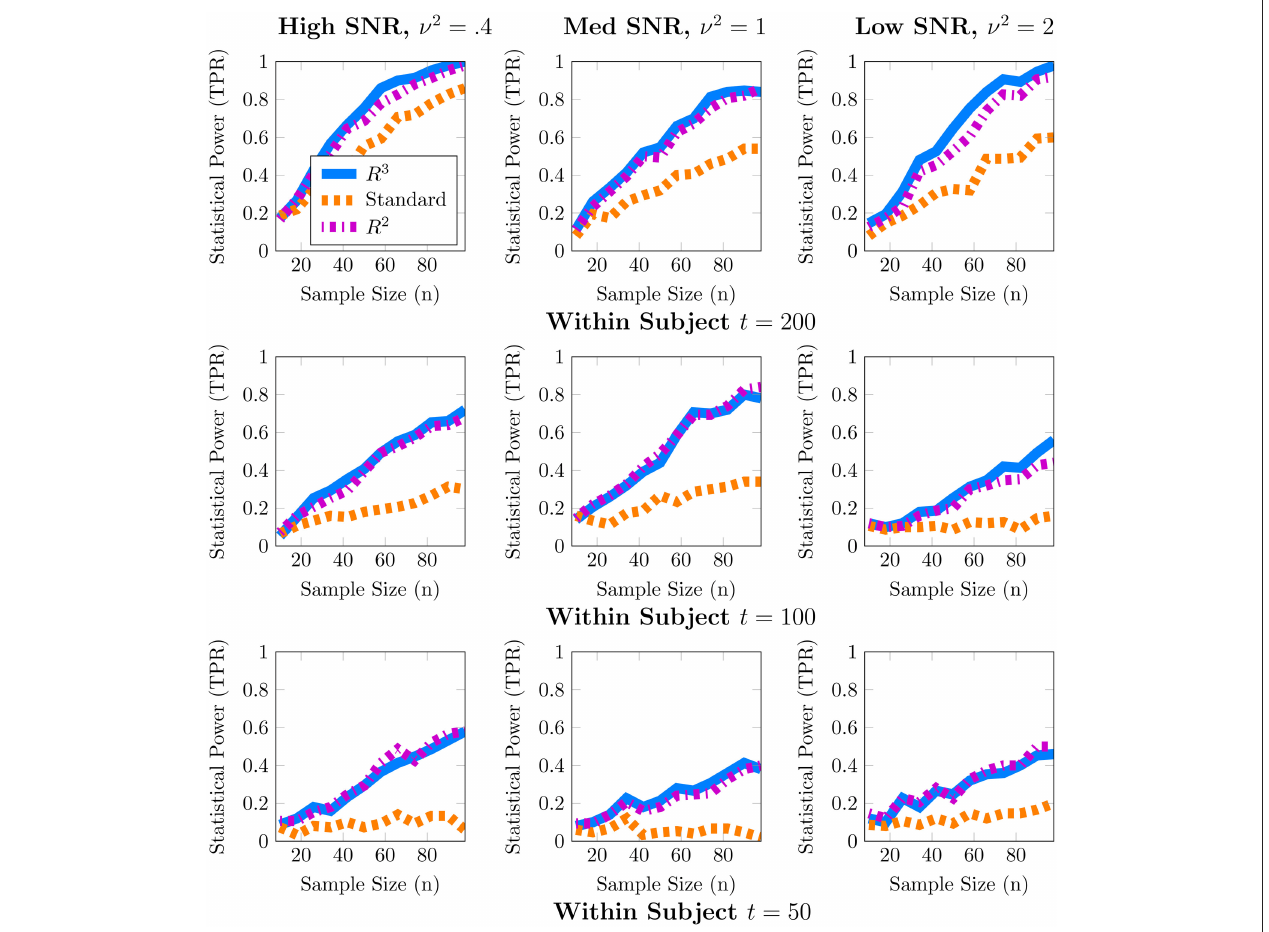
FIGURE 3 | Statistical power for subnetwork density. When subnetwork density varies with an explanatory covariate ( q = 1 ), statistical power to detect this effect improves with subject sample size n but crucially depends on the number of independent fMRI samples t from a single session and the relative size of the covariate effect, β 1 = 2 , to the population variance ν 2 (covariate SNR). For many values of ( t , p ) estimates of subnetwork density are both highly variable and potentially biased. By accounting for these issues, both R 3 and R 2 test statistics substantially improve statistical power across all regimes at smaller subject sample sizes, whereas the standard F -test is substantially less powerful. We note that covariate effects on subnetwork metrics are particularly hard to detect when t ≈ p , with statistical power H 0 often below 60%. Empirical statistical power is defined as # of times reject # of Monte Carlo Trials when the alternative is true in Equation (3)